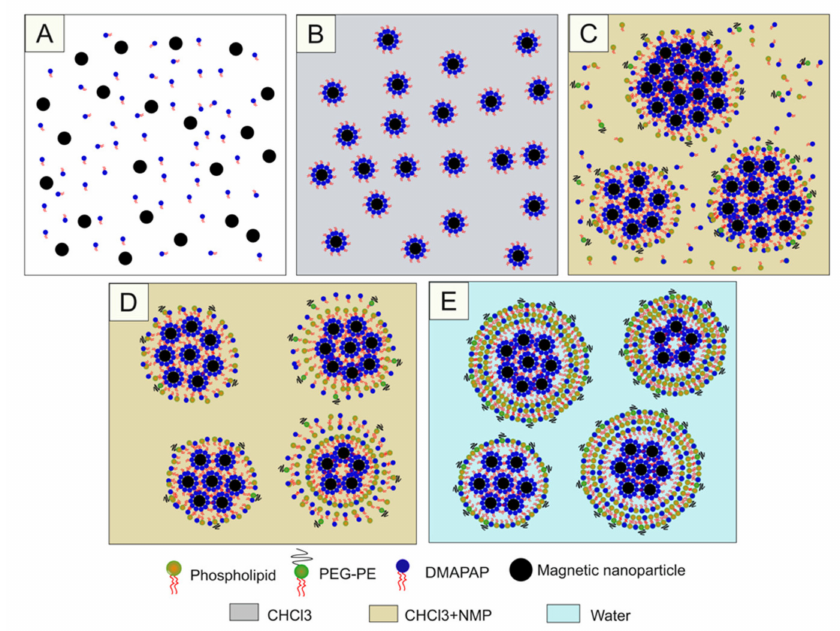
Figure 5. Diagram of MCLs preparation by cosolvent sonication method. Cit-MNPs and DMAPAP were mixed at an equal molar ratio in H 2 O ( A ); The aggregates (FF-DMAPAP) were collected and washed with ethanol before dispersion in CHCl 3 ( B ); Next, FF-DMAPAP were mixed with other lipids in CHCl 3 . Then, a second solvent, N -methyl pyrolidone (NMP), was added ( C ); Due to a long period of sonication, a clear suspension was obtained ( D ); After the evaporation of CHCl 3 , addition of H 2 O, and dialysis, the cationic magnetic liposomes were formed ( E